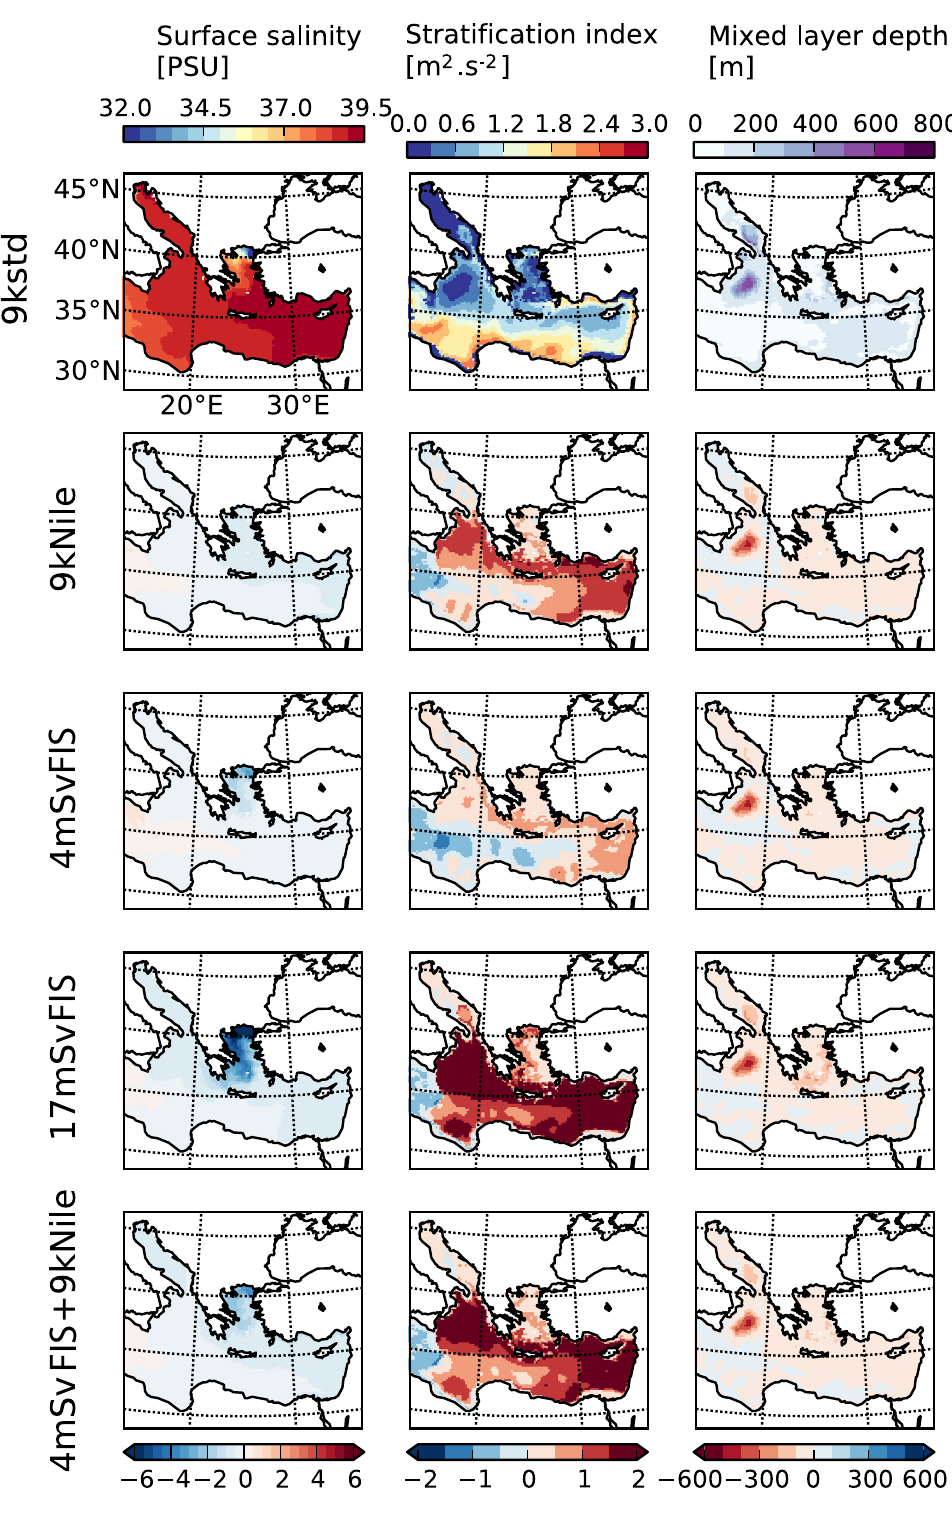
Figure 3. Output of the oceanic model: from left to right, columns are sea surface salinity (PSU), index of stratification (IS, m 2 s −2 ), and mixed layer depth (m). The top row shows their climatological distributions in the “9kstd” simulation, and the remaining rows (from top to bottom) show the anomalies in each of the perturbation simulations. All simulations are at equilibrium. Figures show the average over the last 10 years. Figure have been generated using the Basemap package from Matplotlib (https:// matpl otlib. org/ basem